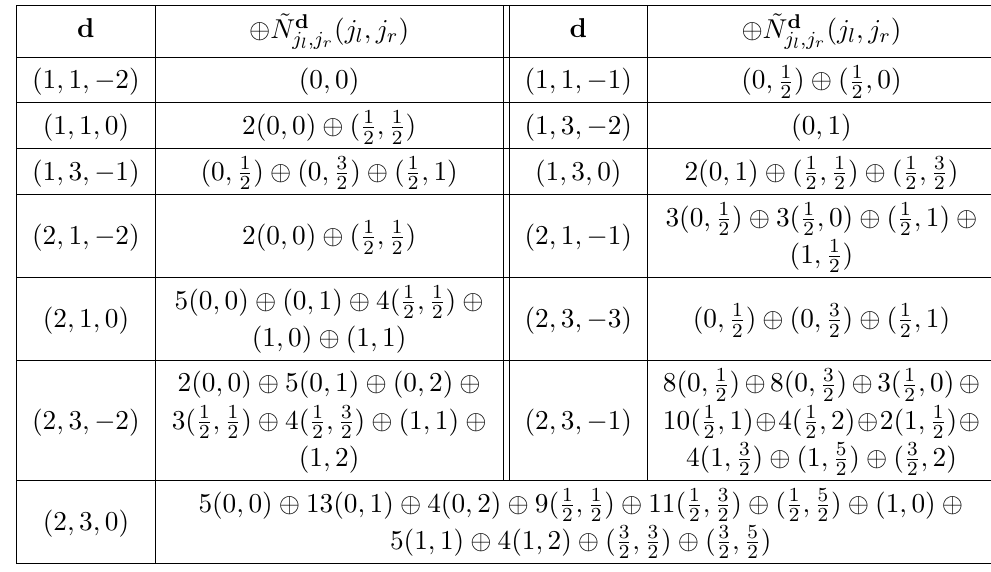
Table 17 . Spectrum of the Wilson surface of r = [ − 1] representation in the 6d N = (2 , 0) A 1 theory for d 1 ≤ 2 and d 2 ≤ 3 . Here, d = ( d 1 , d 2 , d 3 ) labels the BPS states with charge d 1 m 0 + d 2 φ + d 3 m 1 . The states related by the symmetry d 3 ↔ − d 3 are